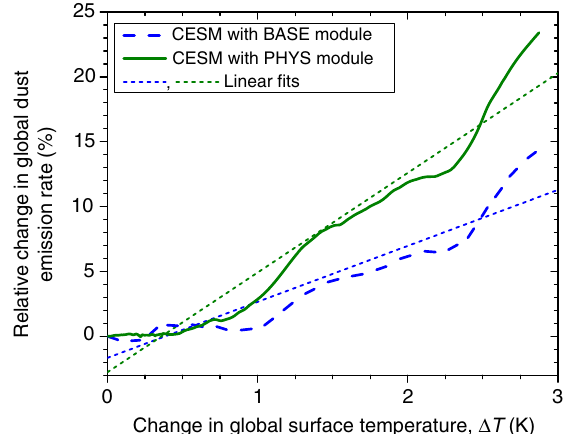
Fig. 2 CESM simulations of the response of the global dust emission rate to future climate change. Shown are changes in the 25-year running average of the global dust emission rate relative to the period 1976 – 2000, as a function of global surface temperature change Δ T , simulated using CLM with the BASE and PHYS dust modules. The dashed lines denote linear least-squares fi ts. The additional dust emission physics in the PHYS